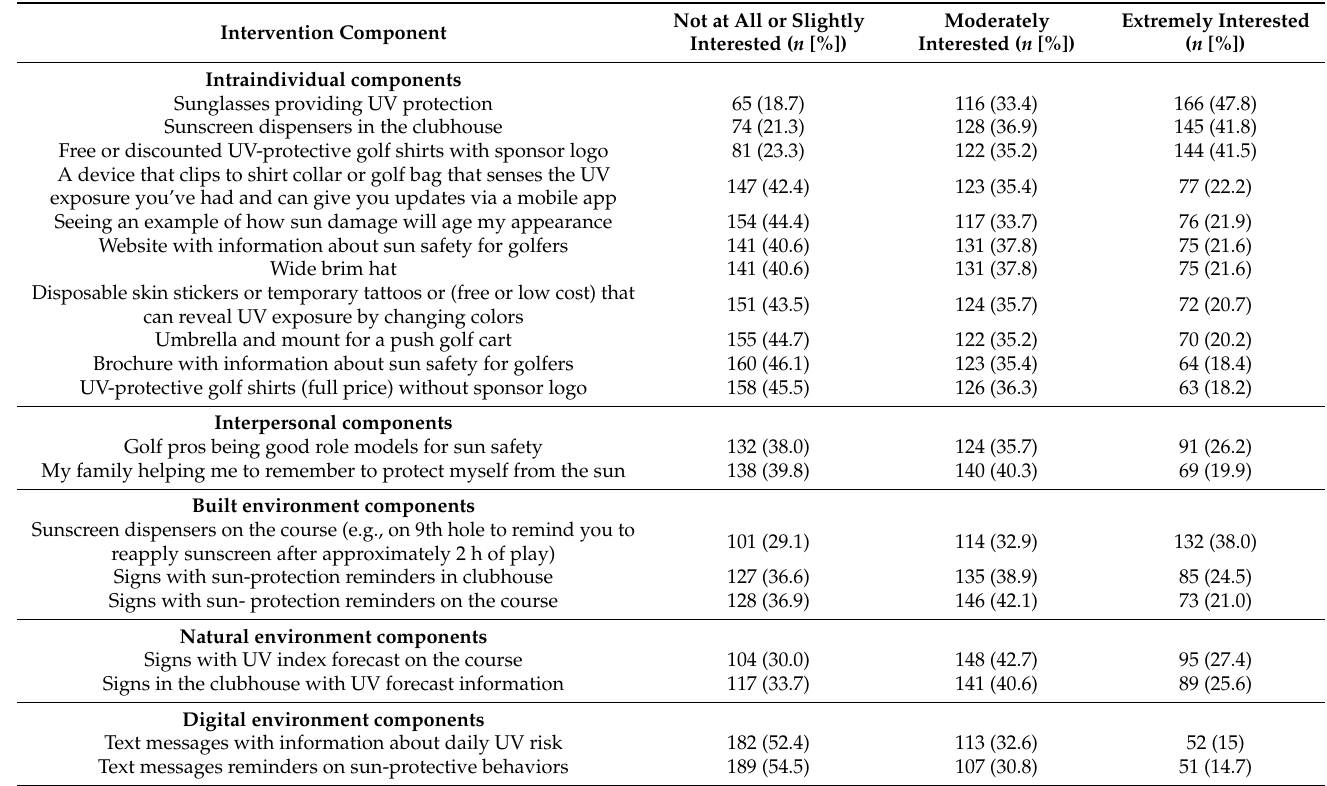
Table 3. Golfers’ interest in components of a sun-safety